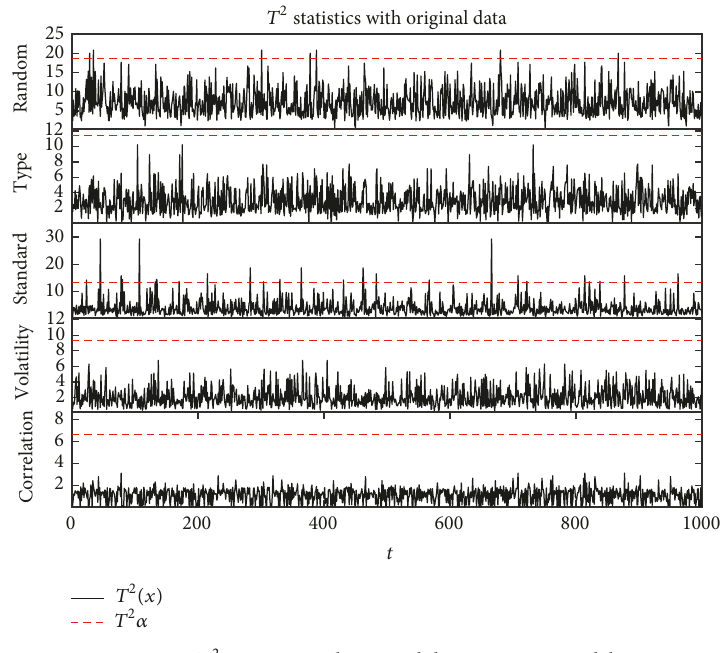
Figure 6: 𝑇 2 statistics with original data in 5 PCA models.